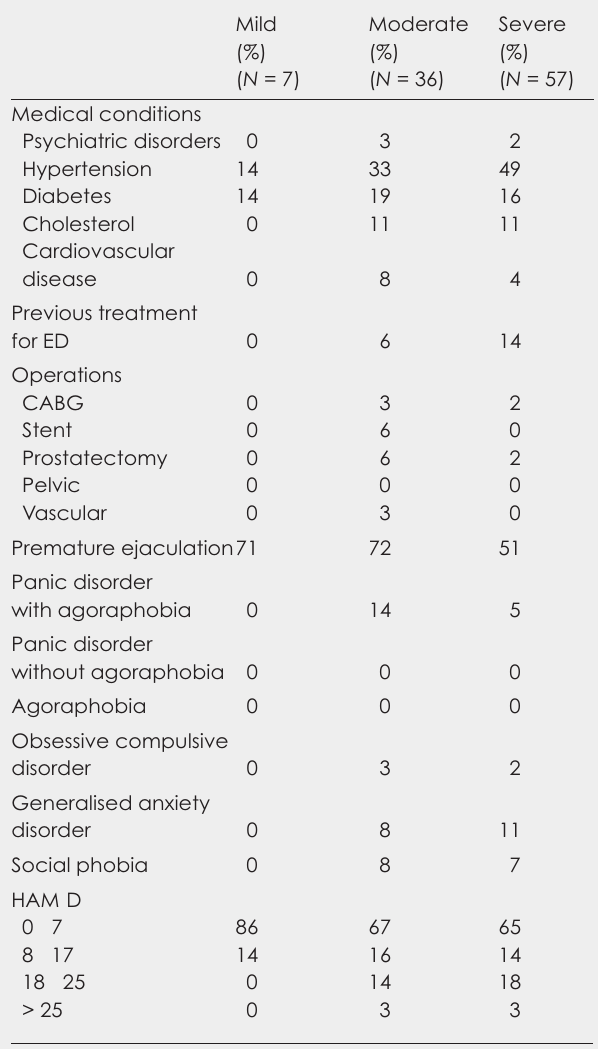
Table IV. Comparison of the severity of erectile dysfunction and risk factors